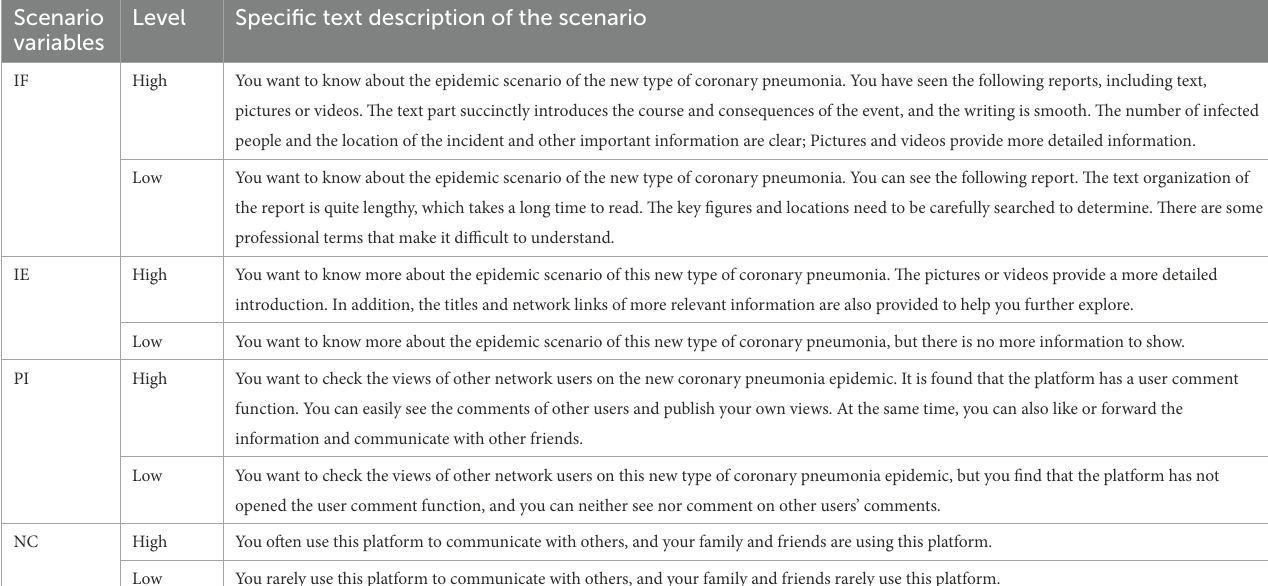
TABLE 5 Scenario variable description.